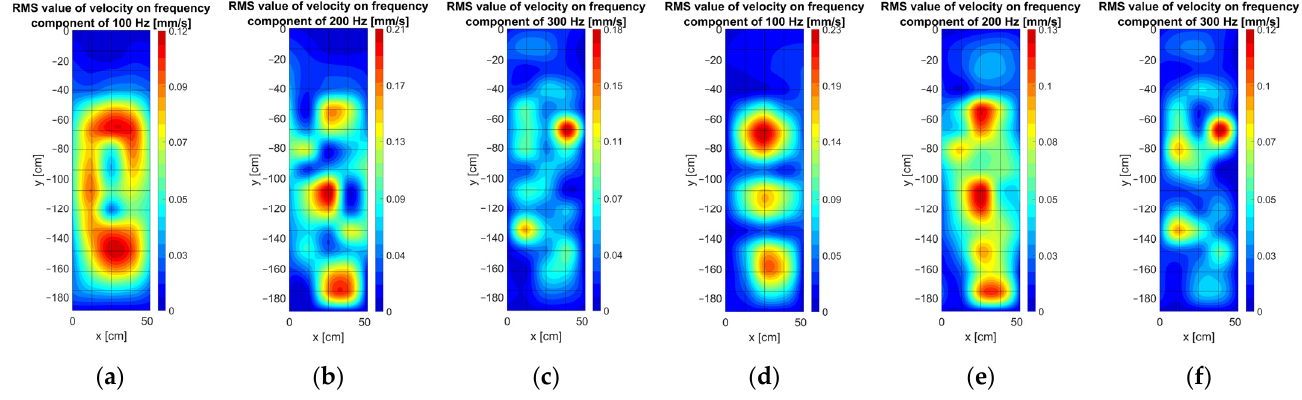
Figure 8. Visualization of RMS values of the vibration velocity on the surface 5 of the transformer using: ( a – c ) power converter and ( d – f ) regulating transformer as a source on different frequency components.